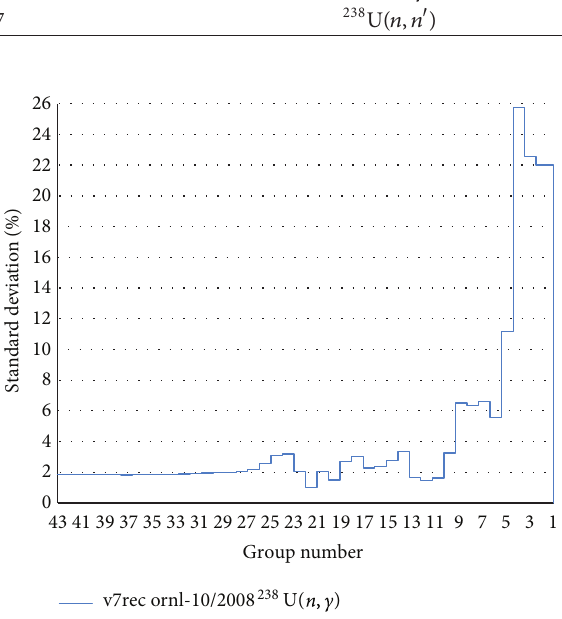
Figure 12: The 2D plot of 238 U( 𝑛, 𝛾 ) covariance by energy